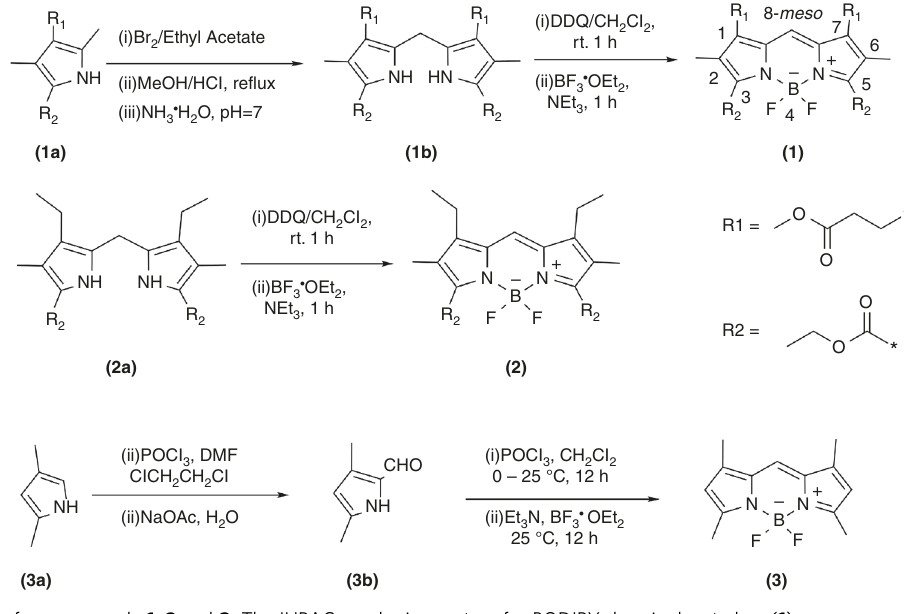
Fig. 7 Synthetic route for compounds 1 , 2 and 3 . The IUPAC numbering system for BODIPY dyes is denoted as ( 1 )